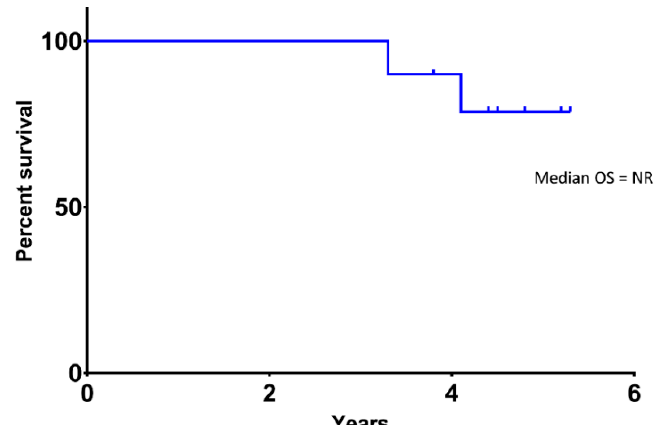
Figure 2. Overall Survival (OS) in High-Risk Uveal Melanoma Patients Receiving Adjuvant Ipilimumab.